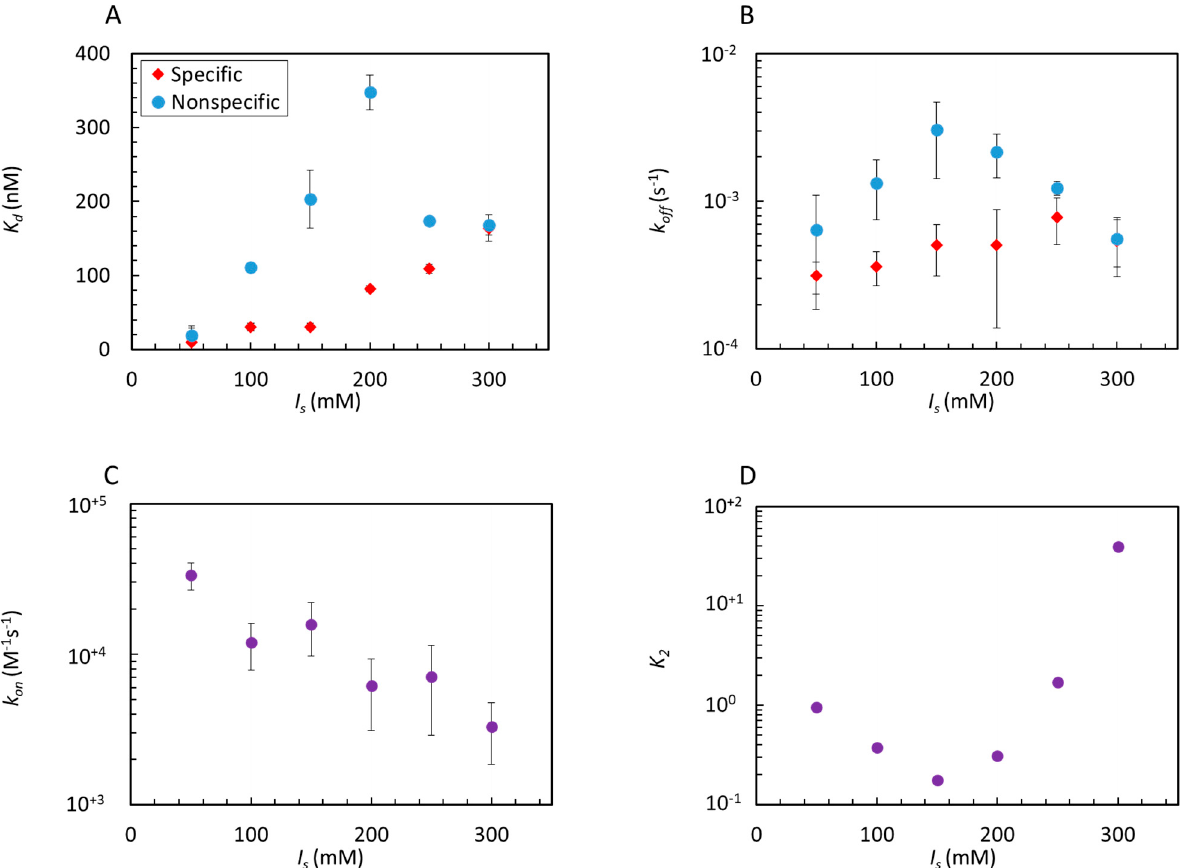
Figure 3. Effect of ionic strength on Gal4–DNA interactions. Equilibrium dissociation constants K d ( A ) and dissociation rates k off ( B ) for specific (red) and nonspecific (blue) hairpin sequences. ( C ) Association rate k on , common to specific and nonspecific strands (purple). ( D ) Estimated specific dissociation constant K 2 from Equation (3).